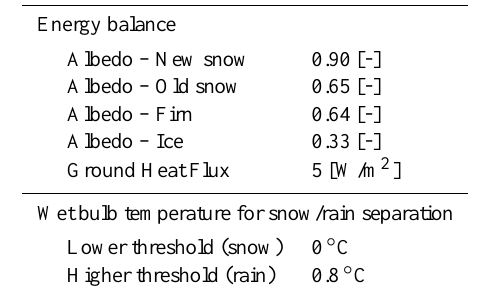
Table 2. Final values of calibrated snow